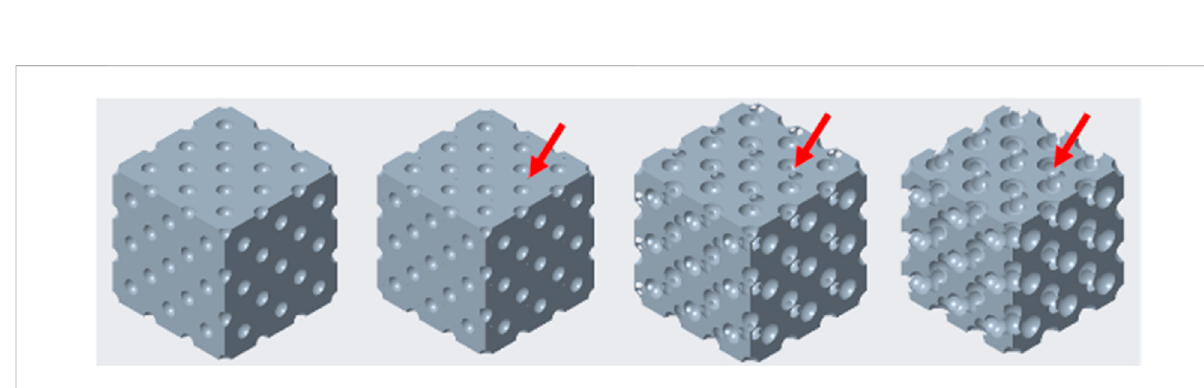
FIGURE 15 Closed-cell and open-cell structure of diamond-based alignment (from left to right 15.74%, 31%, 59.7% and 76%